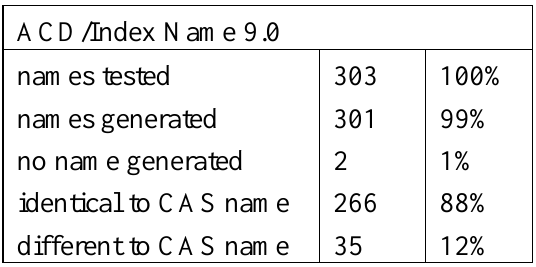
Table 1 . Agreement of generated Index names (ACD/Index Name 9.0) with the officially registered ones (CAS).